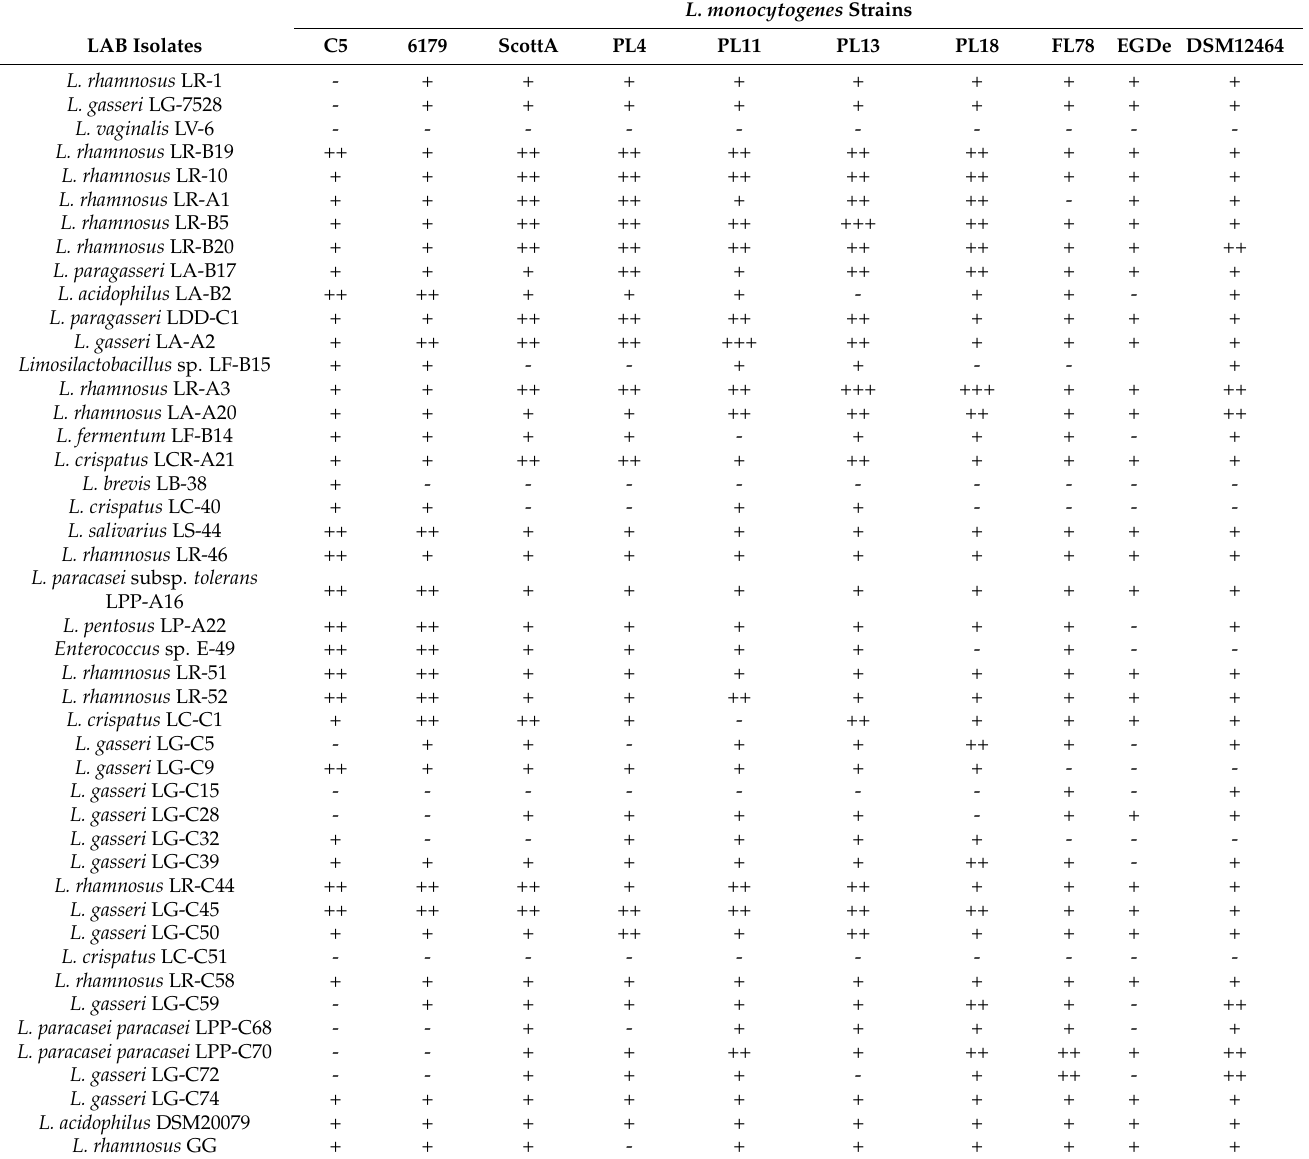
Table 3. Antimicrobial activity of the LAB isolates against the L. monocytogenes